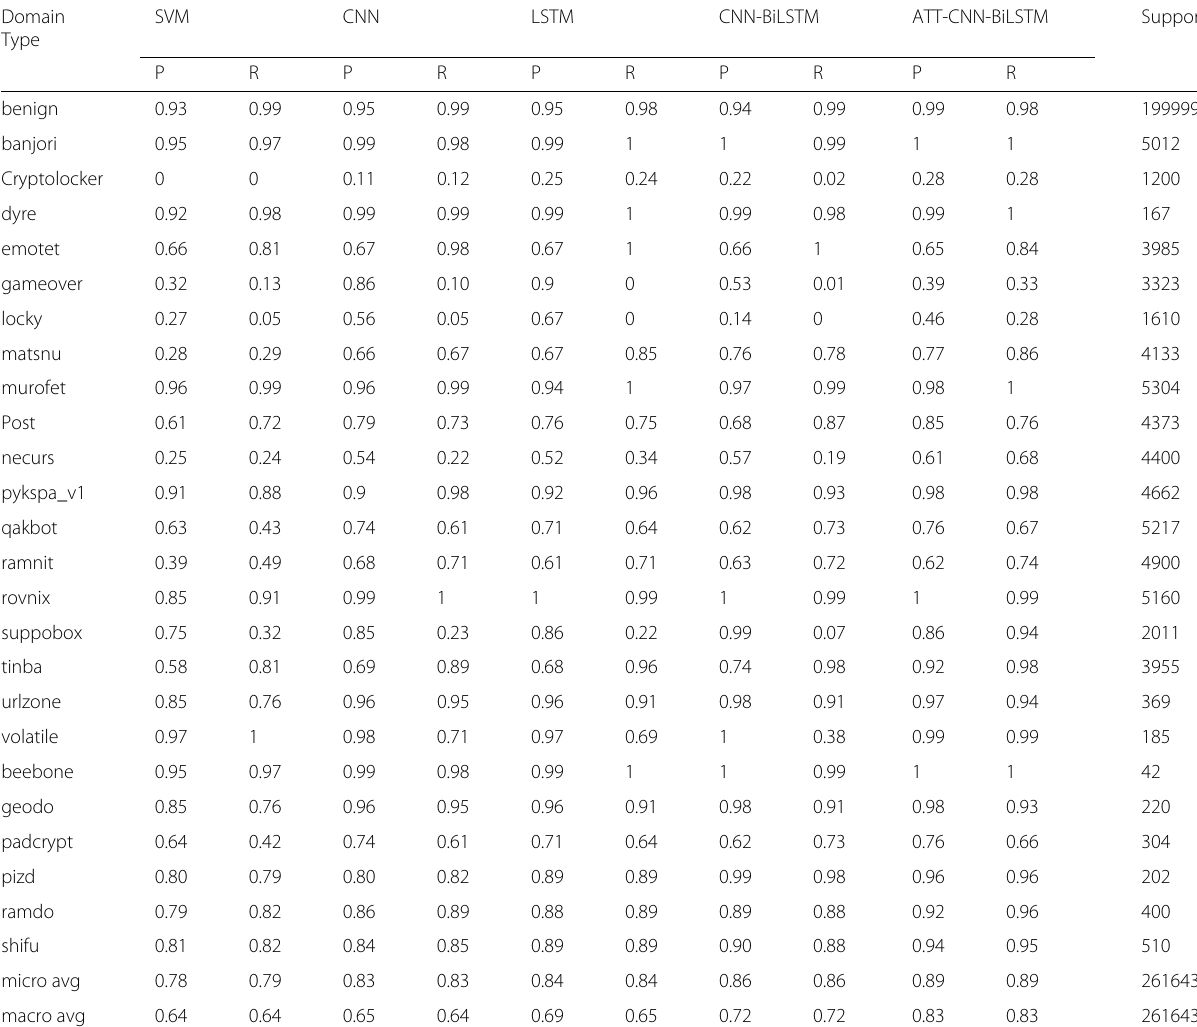
Table 3 Comparison of precision and recall for classification task on the Models Domain